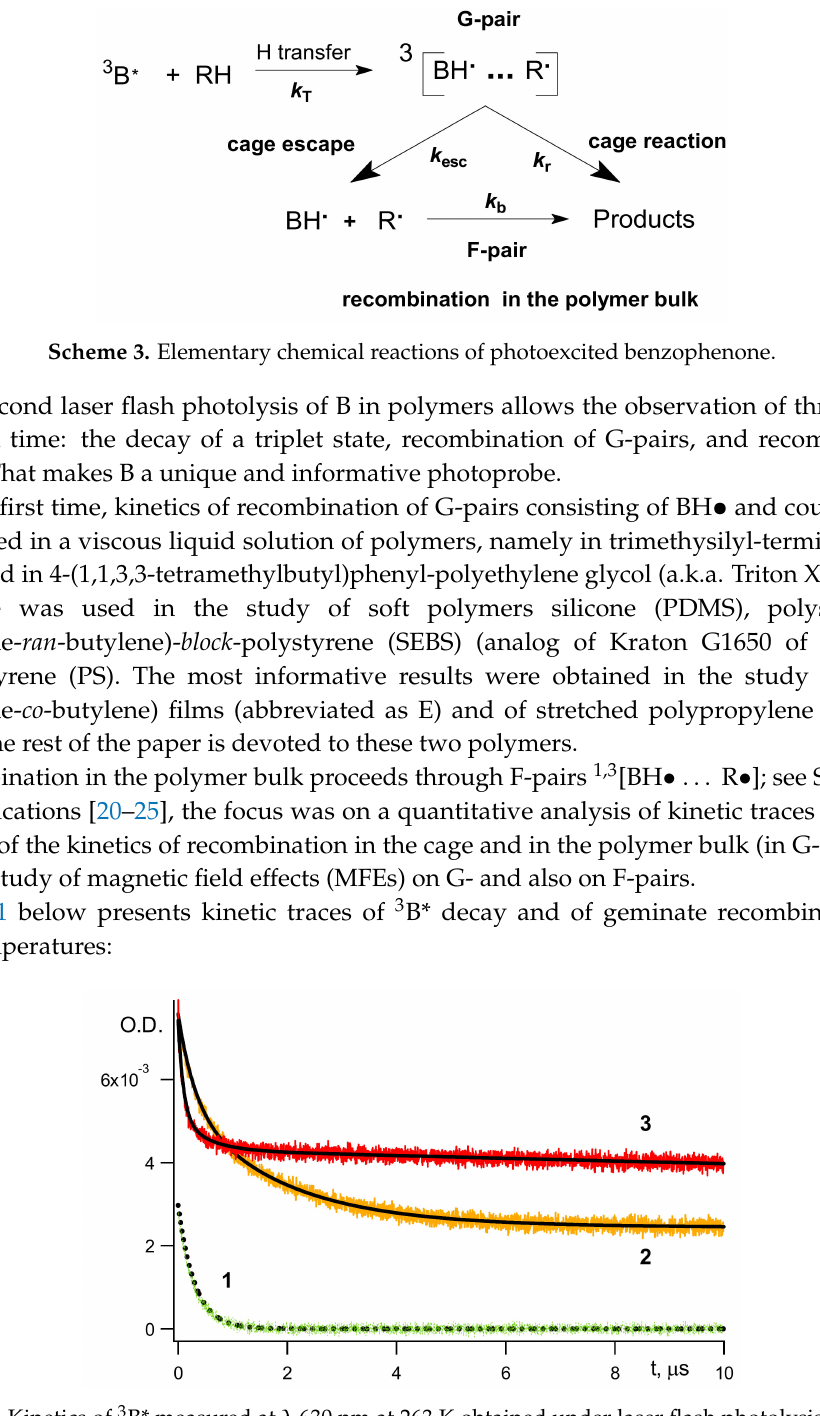
Figure 1. Kinetics of 3 B* measured at λ 630 nm at 263 K obtained under laser flash photolysis of B in E film (1); decay kinetics of BH • measured at λ 545 nm at 263 (2) and at 313 K (3) in the same film. Solid black lines are the computer fit of the experimental curves. In this figure and in figures below, O.D. stands for optical density. Adapted from Ref.